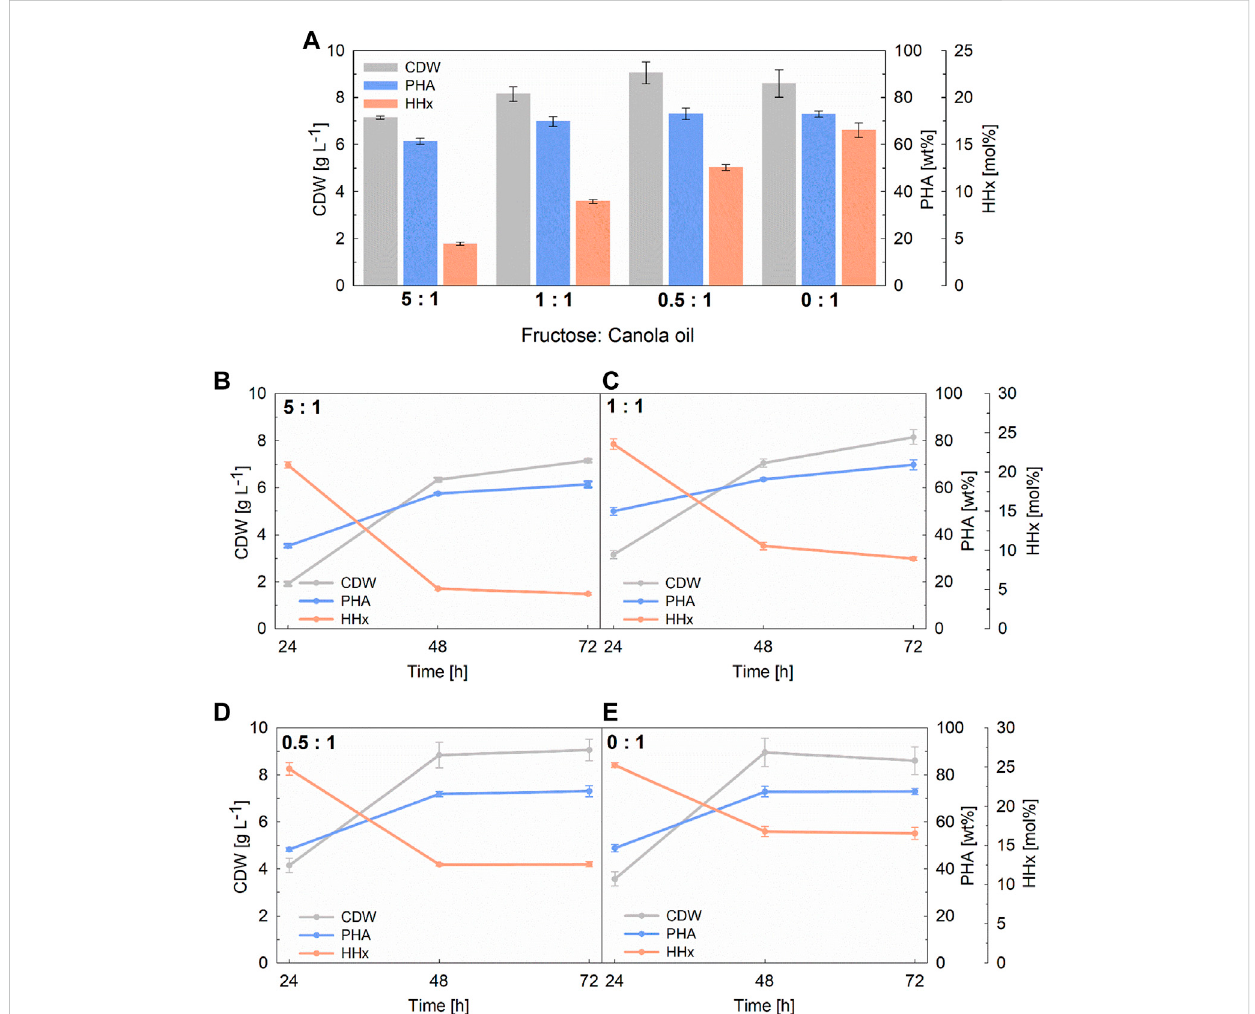
FIGURE 3 100-mL shake fl ask cultivations with R. eutropha Re2058/pCB113 using fructose and canola oil mixtures as carbon source and urea as nitrogen source. Final yields of cell dry weight (CDW; g L − 1 ), PHA content of CDW (PHA; wt%) and HHx content of PHA (HHx; mol%) after 72 h are shown in (A) as wellasvaluesevery24hforeachcultivationwith5:1 (B) ,1:1 (C) ,0.5:1 (D) ,and0:1 (E) fructosetocanolaoilratio.Allcultivationshada fi nalcarboncontent of 10 g L − 1 with a C/N ratio of 22 g g − 1 . The carbon ratio of fructose to canola oil (g g − 1 ) is indicated for each mixture. Error bars indicate standard deviation from biological